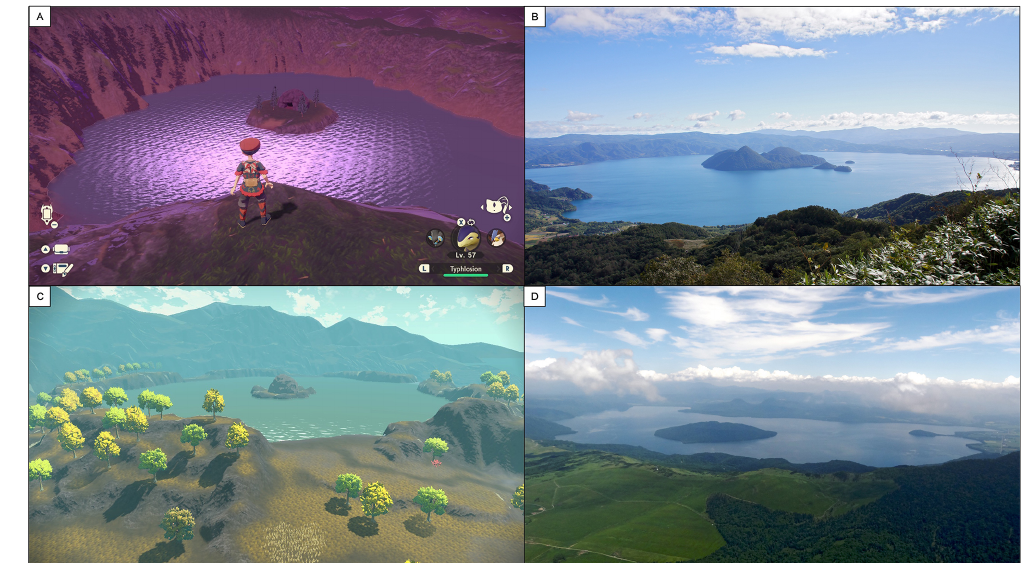
Figure 6. Comparison image of in-game and real-world inspiration. (a) Lake Verity, Obsidian Fieldlands, with caldera rim and lava dome island in Pokémon Legends: Arceus (Fig. 1a4) ©The Pokémon Company International (2022a). (b) Photograph of Lake T¯oya, Hokkaido, with Nakajima Island, Japan (Fig. 1b3) (633highland, 2013a). (c) Lake Valor, Crimson Mirelands, with caldera rim and lava dome island in Pokémon Legends: Arceus (Fig. 1a5) ©The Pokémon Company International (2022a). (d) Photograph of Lake Kussharo, Hokkaido, with Nakajima Island, Japan (Fig. 1b4) (633highland,